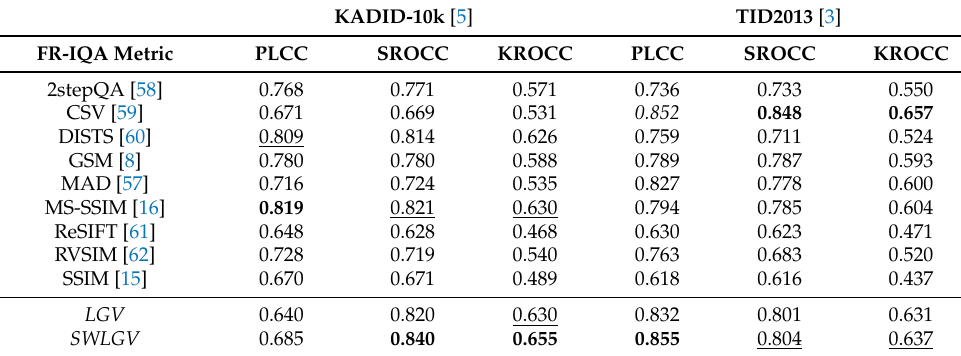
Table 2. Comparison of LGV and SWLGV to the state-of-the-art on KADID-10k [5] and TID2013 [3]. The highest values are typed in bold , while the second highest ones are